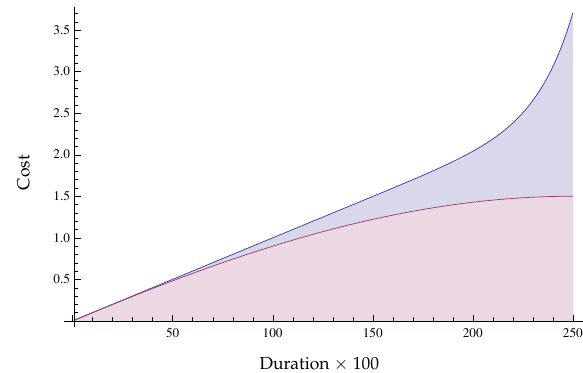
( 1, r ) (Violet) and Cost OFFLINE (Purple). e